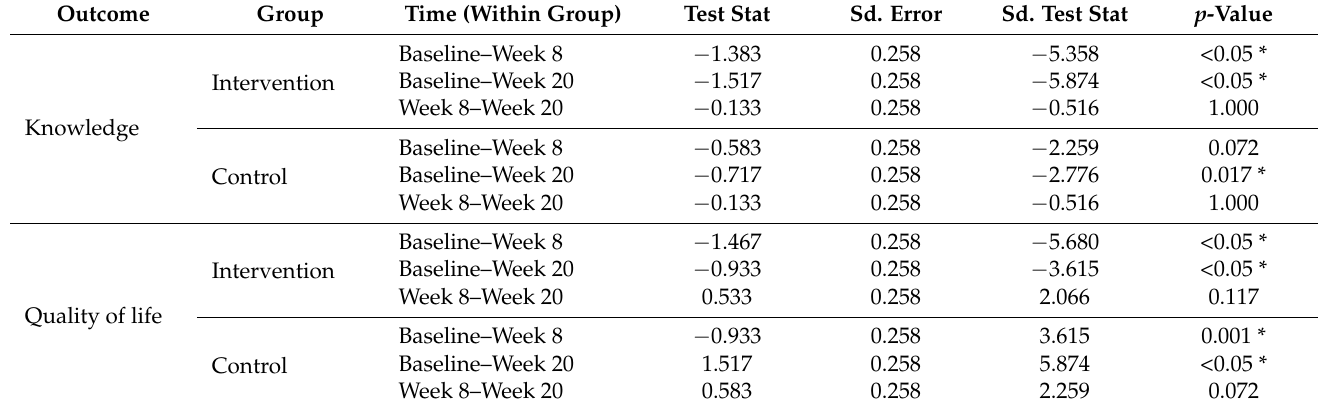
Table 5. Comparison of knowledge and quality of life scores for the baseline, at the end of the program (week 8), and at the follow-up (week 20) ( n = 30).